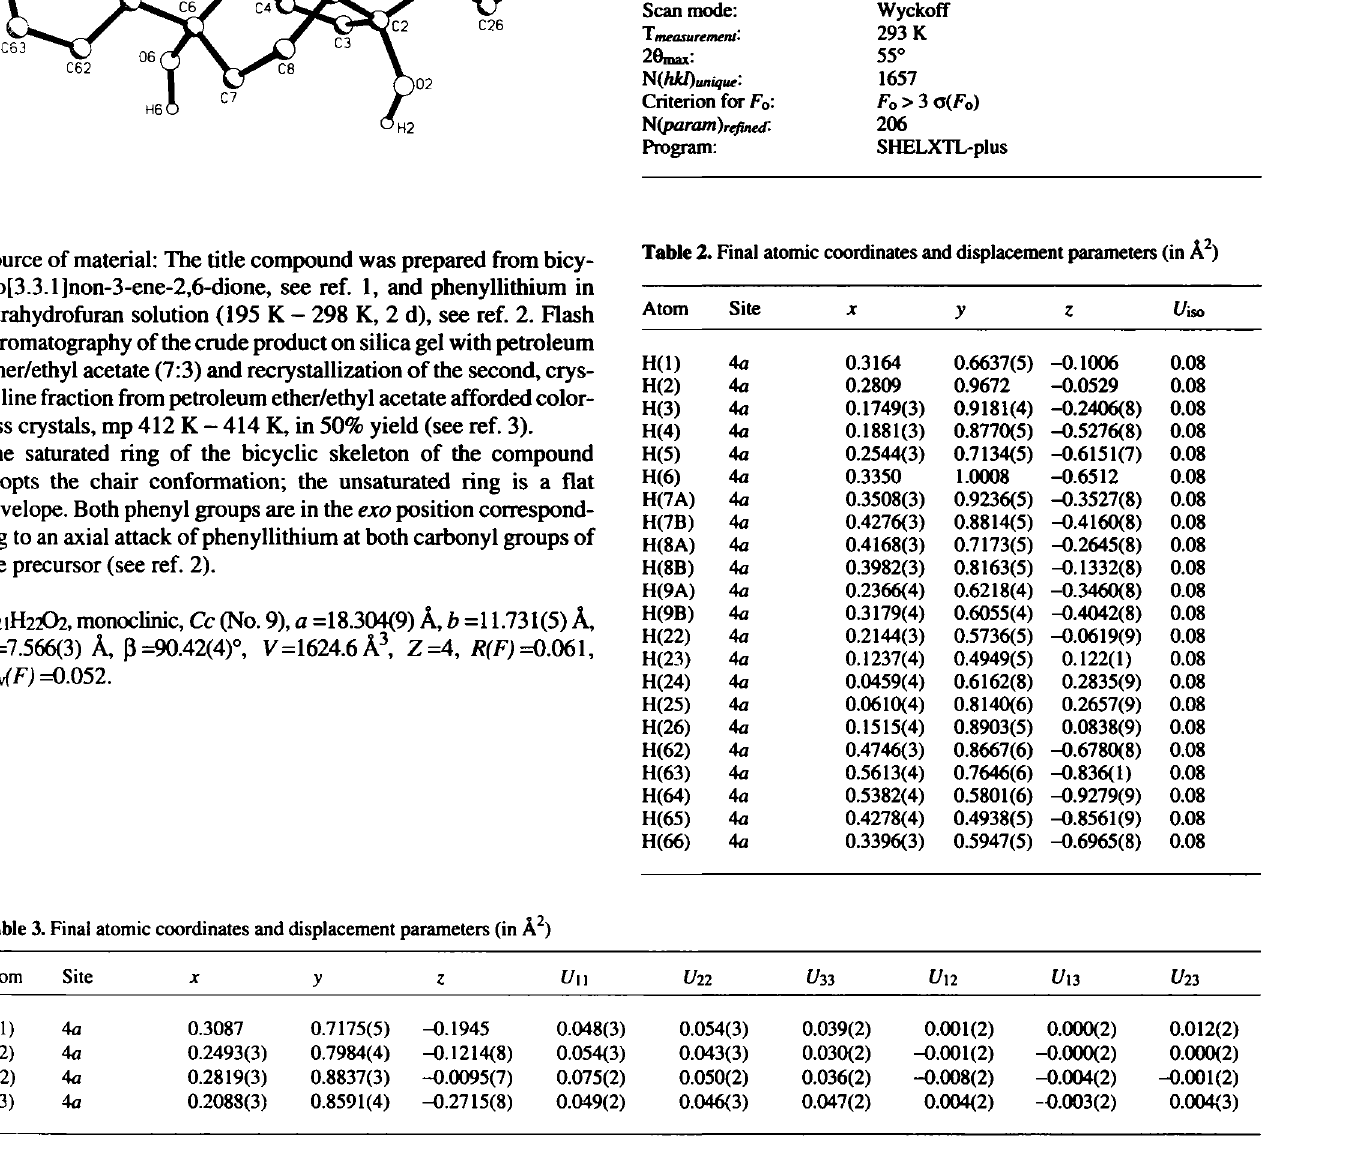
Table 1. Parameters used for the X-ray data collection Crystal: